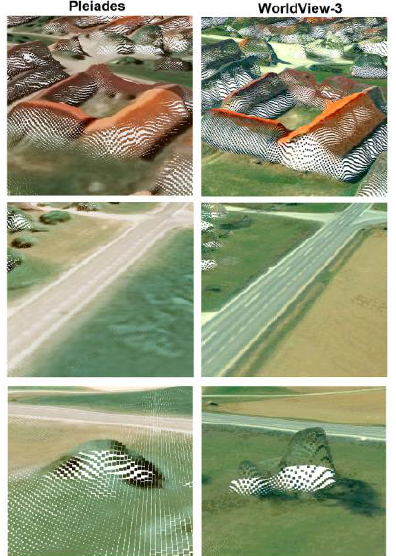
Figure 4. Comparative examples of Pléiades (left) and WorldView-3 (right) point clouds for buildings (first row), roads (second row) and trees (third row)